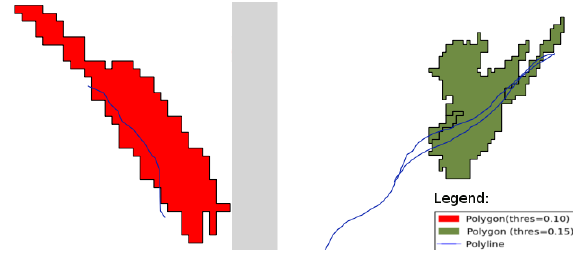
Figure 4: Polyline to polygon landslide segment via segmentation Object oriented segmentation based on region growing, groups similar pixel, given multi-layered data. The number and size of the segments are determined by a threshold value that affects the merger between segments based on a similarity measure. The threshold value is an important parameter for extracting desired objects. Landslides, for the given grouping of data layers used, were found to be best segmented with a threshold value of 0.1 and 0.15. These values were selected based on the assumption that for